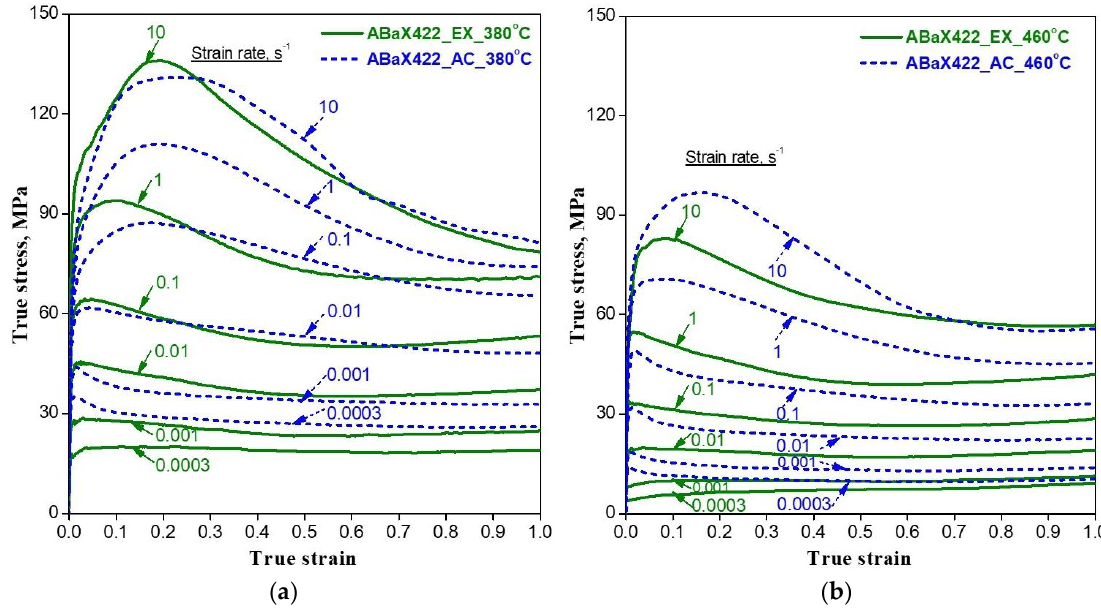
Figure 2. True stress–true strain curves obtained in compression at ( a ) 380 °C and ( b ) 460 °C at different strain rates for the ABaX422 alloy, in both as-cast condition and extruded conditions.